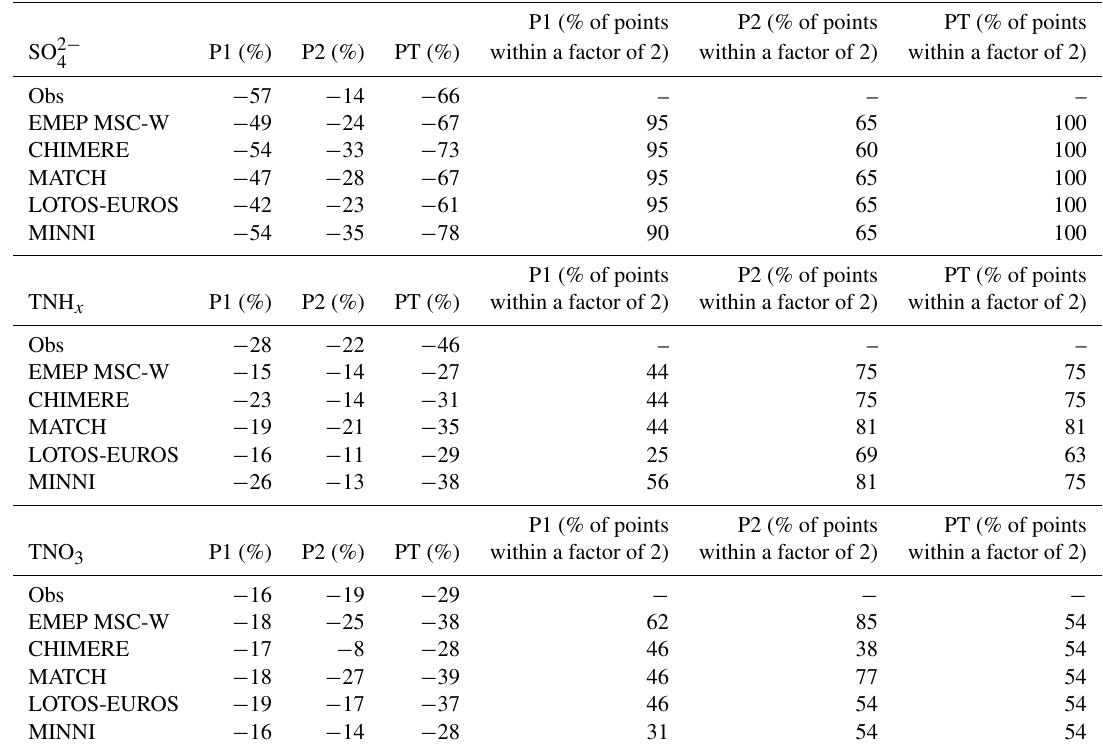
, TNH x and TNO 3 4